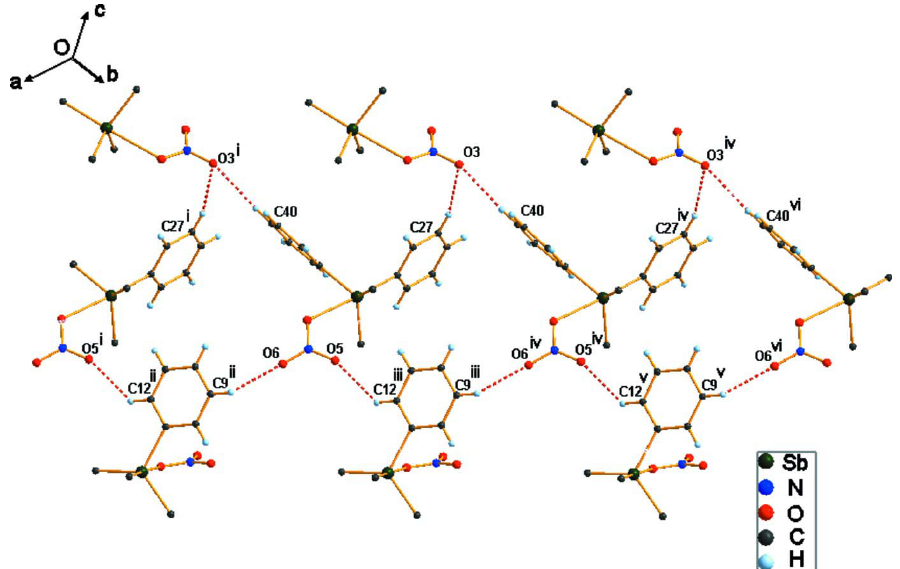
Figure 2 A partial packing diagram of the title compound showing the formation of chains linked by C—H···O interactions (dotted lines) [Symmetry codes: (i) = 1/2+x, 1/2+y, z; (ii) = 1/2+x, 1/2-y, -1/2+z; (iii) = x, -y, -1/2+z; (iv) = -1/2+x, -1/2+y, z; (v) -1/2+x, -1/2-y -1/2+z; (vi) -1+x, -1+y,